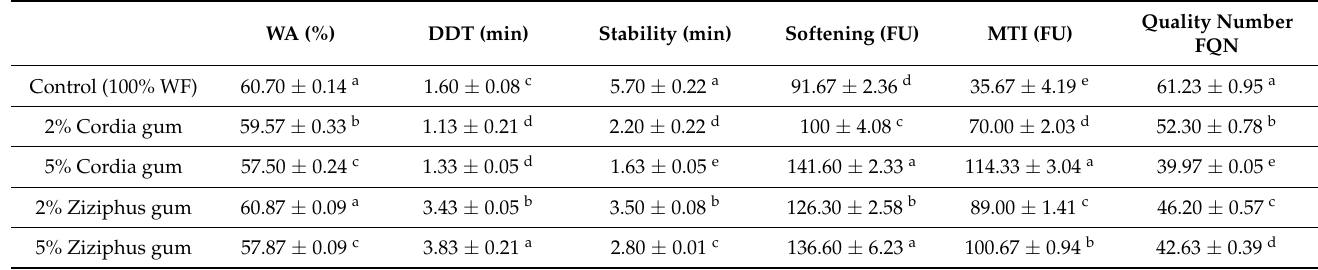
Table 1. Dough development characteristics of flour gum